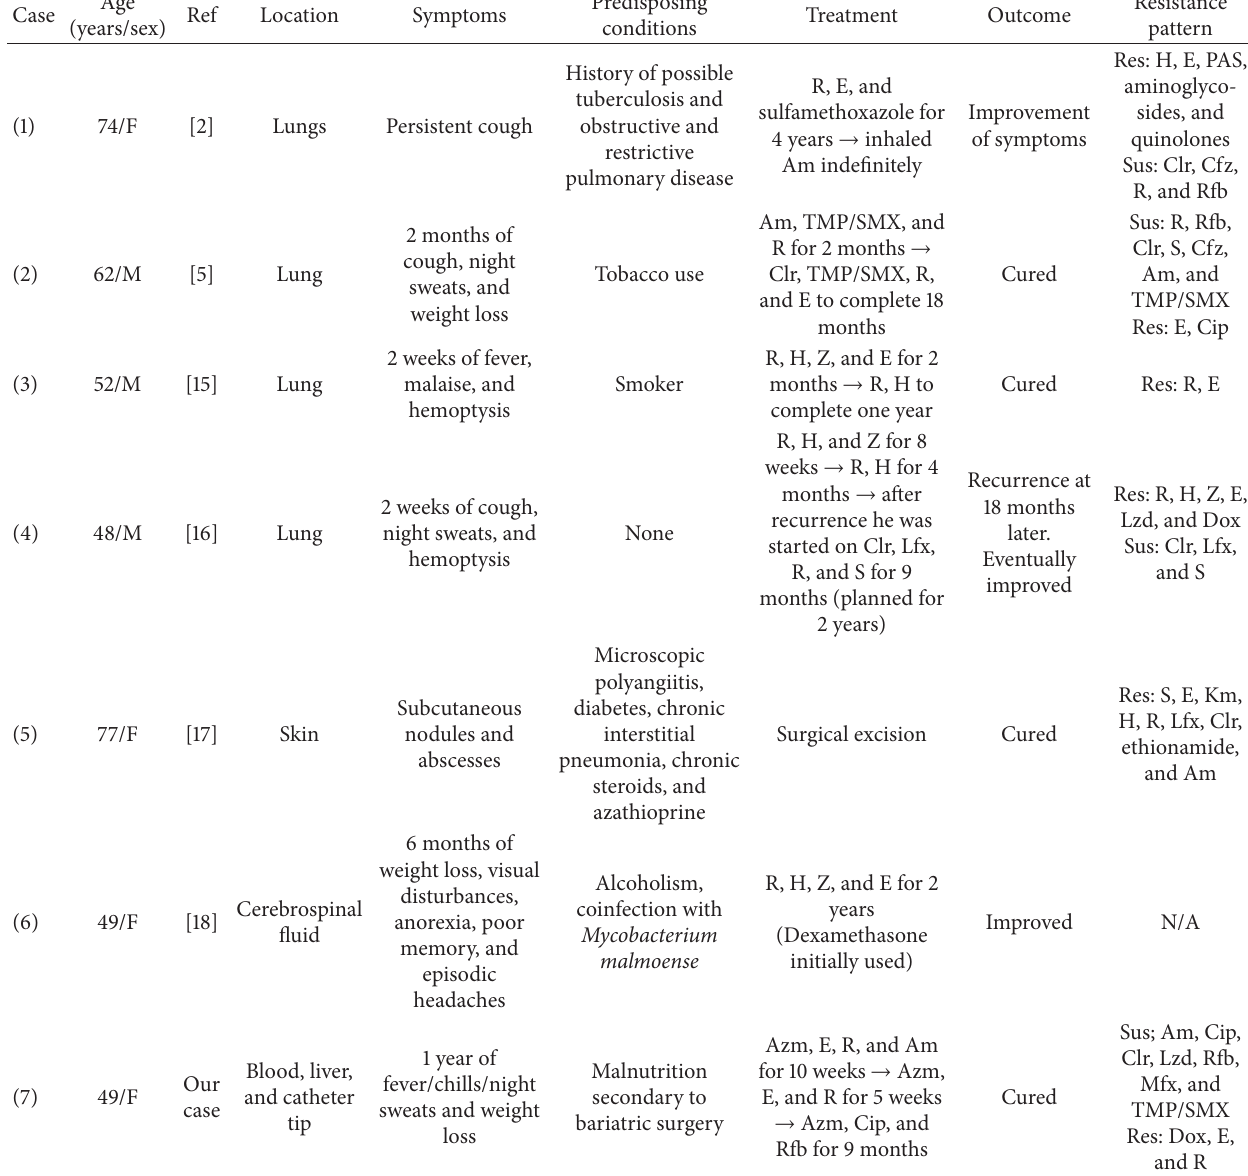
Table 1: Reported Mycobacterium interjectum cases in